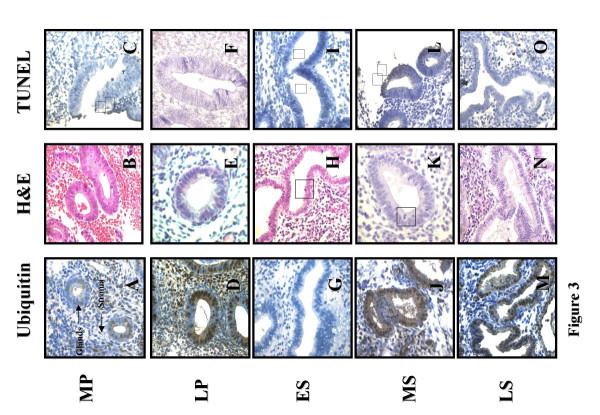
Immunohistochemical staining of control endometrium. Panels A, D,G,J and M are ubiquitin stained sections where brown cells are ubiquitin labelled (X400). Panels B, E, H, K and N are H&E stained sections where □ are apoptotic cells (X600). Panels C, F, I, L and O are TUNEL stained sections where ▼ are TUNEL positive cells.; Menstrual cycle phases: MP = mid proliferative; LP = late proliferative; ES = early secretory; MS = mid secretory and LS = late secretory.